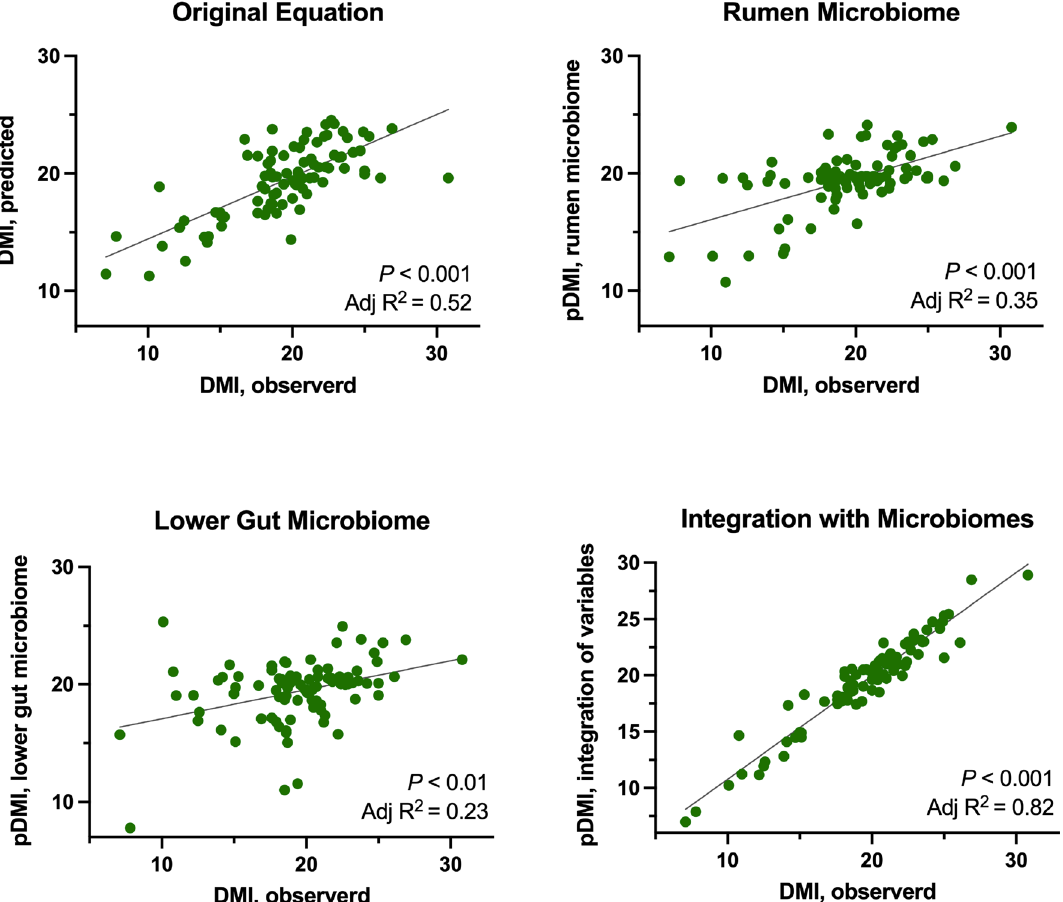
Figure 6. Correlation of dry matter intake with the rumen and lower gut microbiomes as well as the overall gut microbiome of lactating dairy cows. Regression was based on the original equation used for residual feed intake (RFI), followed by equations using the ASVs associated with the variables from the RFI equation corrected by dry matter intake (DMI; kg/d) from either the rumen or lower gut microbiomes, and equations integrating the RFI variables with the ASVs associated with RFI variables corrected by DMI (kg/d) from both the rumen and lower gut microbiomes. Significance was declared at P ≤